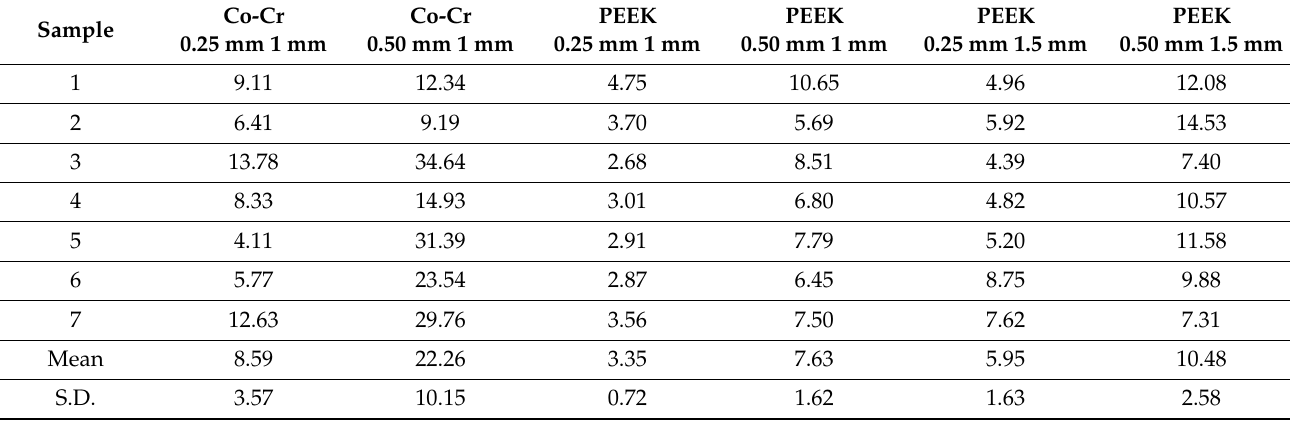
Table 2. The initial retentive forces (N).